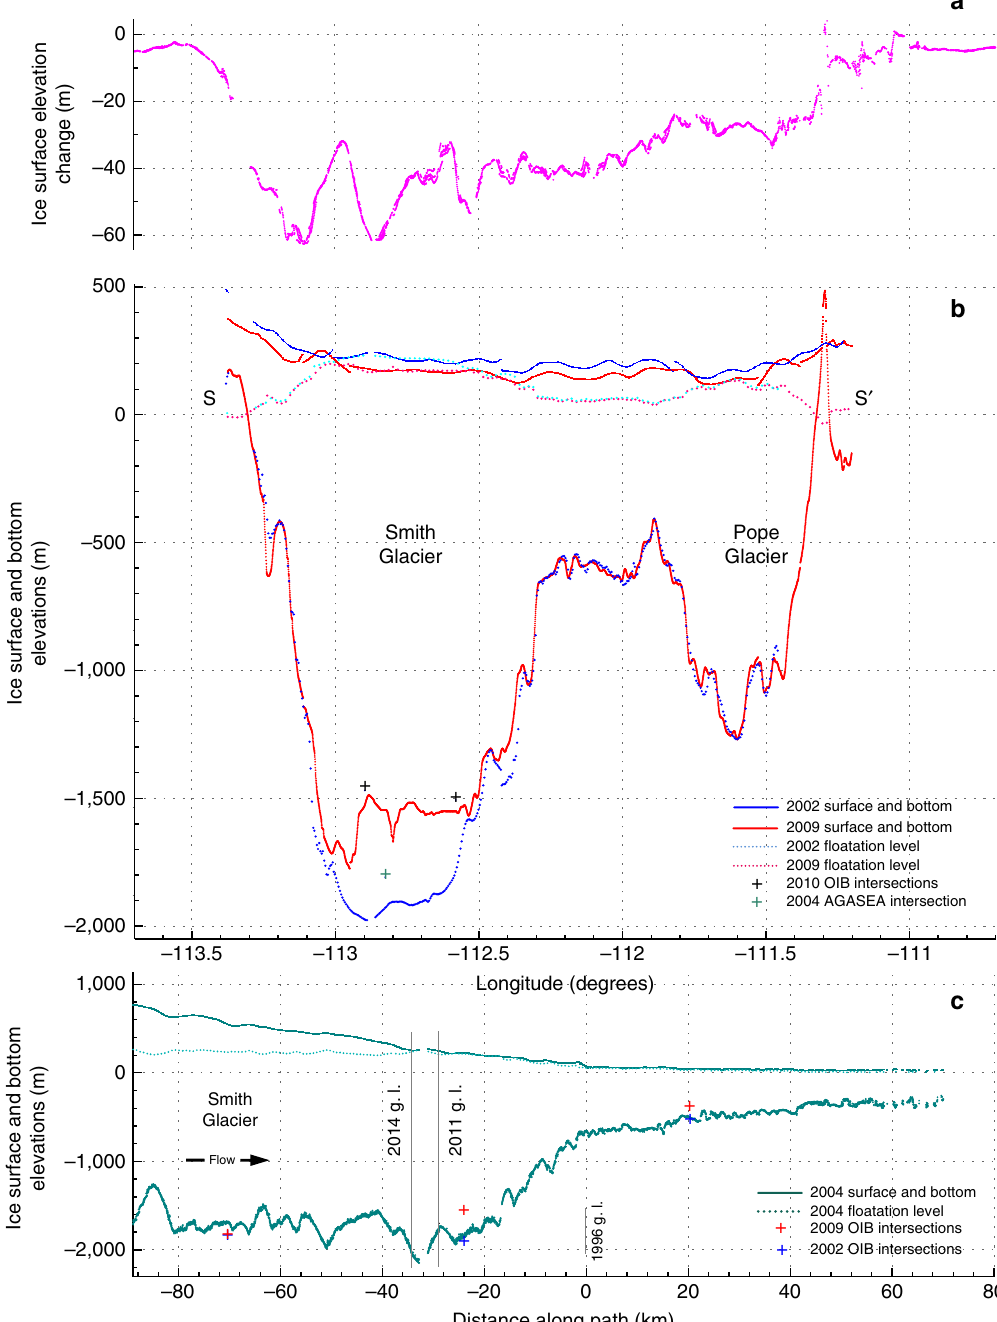
Figure 2 | Smith Glacier radar transects showing basal ice loss and corresponding surface elevation change between the years 2002 and 2009. ( a ) Surface elevation change between 2002 and 2009 as measured by ATM laser altimetry on the across-flow Smith Glacier (SG) transect delimited by S-S 0 shown in Fig. 1a. ( b ) The 2002 and 2009 ice surface and bottom MCoRDS profiles of SG along the transect delimited by S-S 0 in Fig. 1a. The hydrostatic floatation levels were found by taking freeboard elevation to be 0.12 of ice thickness, which was inferred from floating ice in Figs 3b and 4b; and taking sea surface to be at (cid:2) 33.9m relative to the WGS84 ellipsoid, which was found from ATM 2009 measurements of ocean surface height in front of the Dotson Ice Shelf. The 2002 ice bottom appears partially dotted at some locations due to the lower density of available measurements there. ( c ) Ice surface and bottom along-flow profiles following the entire 2004 AGASEA trajectory shown in Fig. 1b. In this and subsequent figures the vertical grey lines mark grounding line locations. The 1996 grounding line location is taken as the origin of the x axis representing the distance along the flight path, and is indicated by a shorter grey line when bed topography is not available at its